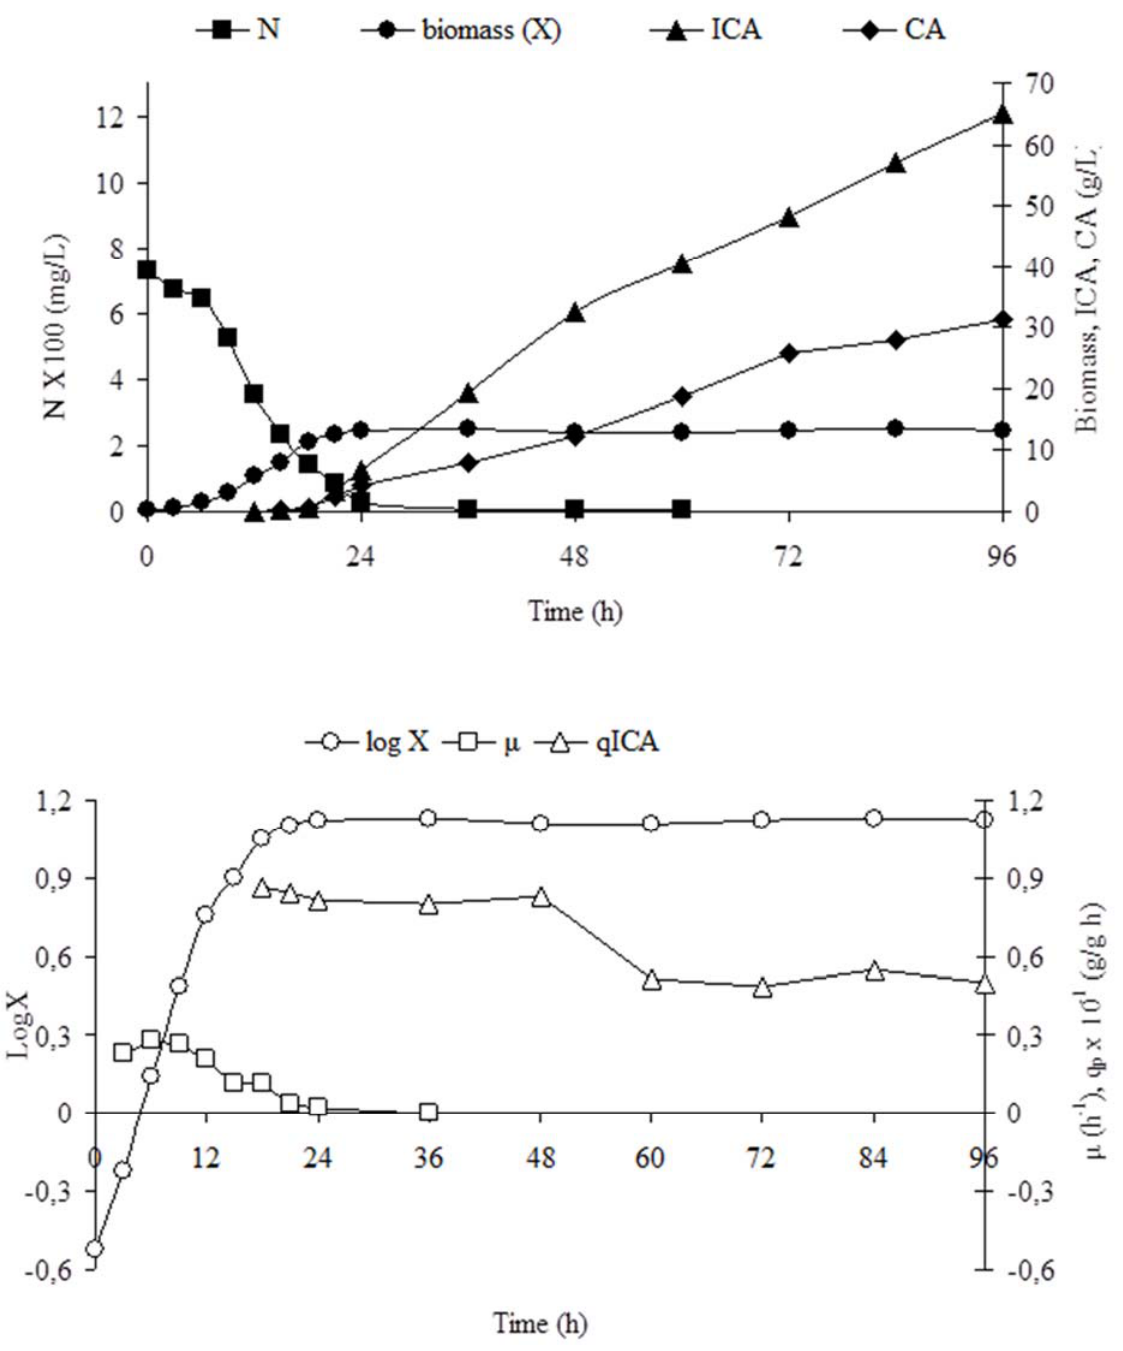
Figure 1. Time course of growth of Y. lipolytica VKM Y-2373, nitrogen consumption, citric acids production in the medium with EAF ( top ) and the calculated parameters of ICA production ( bottom ). N—nitrogen; ICA—isocitric acid; CA—citric acid; logX—logarithm of biomass; µ —the specific growth rate; q ICA —the specific rate of ICA synthesis.